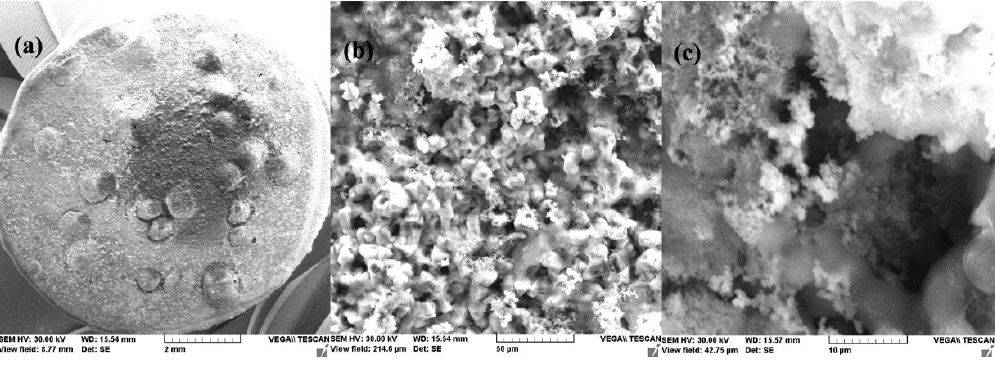
Figure 16. The equivalent circuits used to model EIS data in samples immersed in seawater for ( a ) 36 days or ( b ) 78 days.